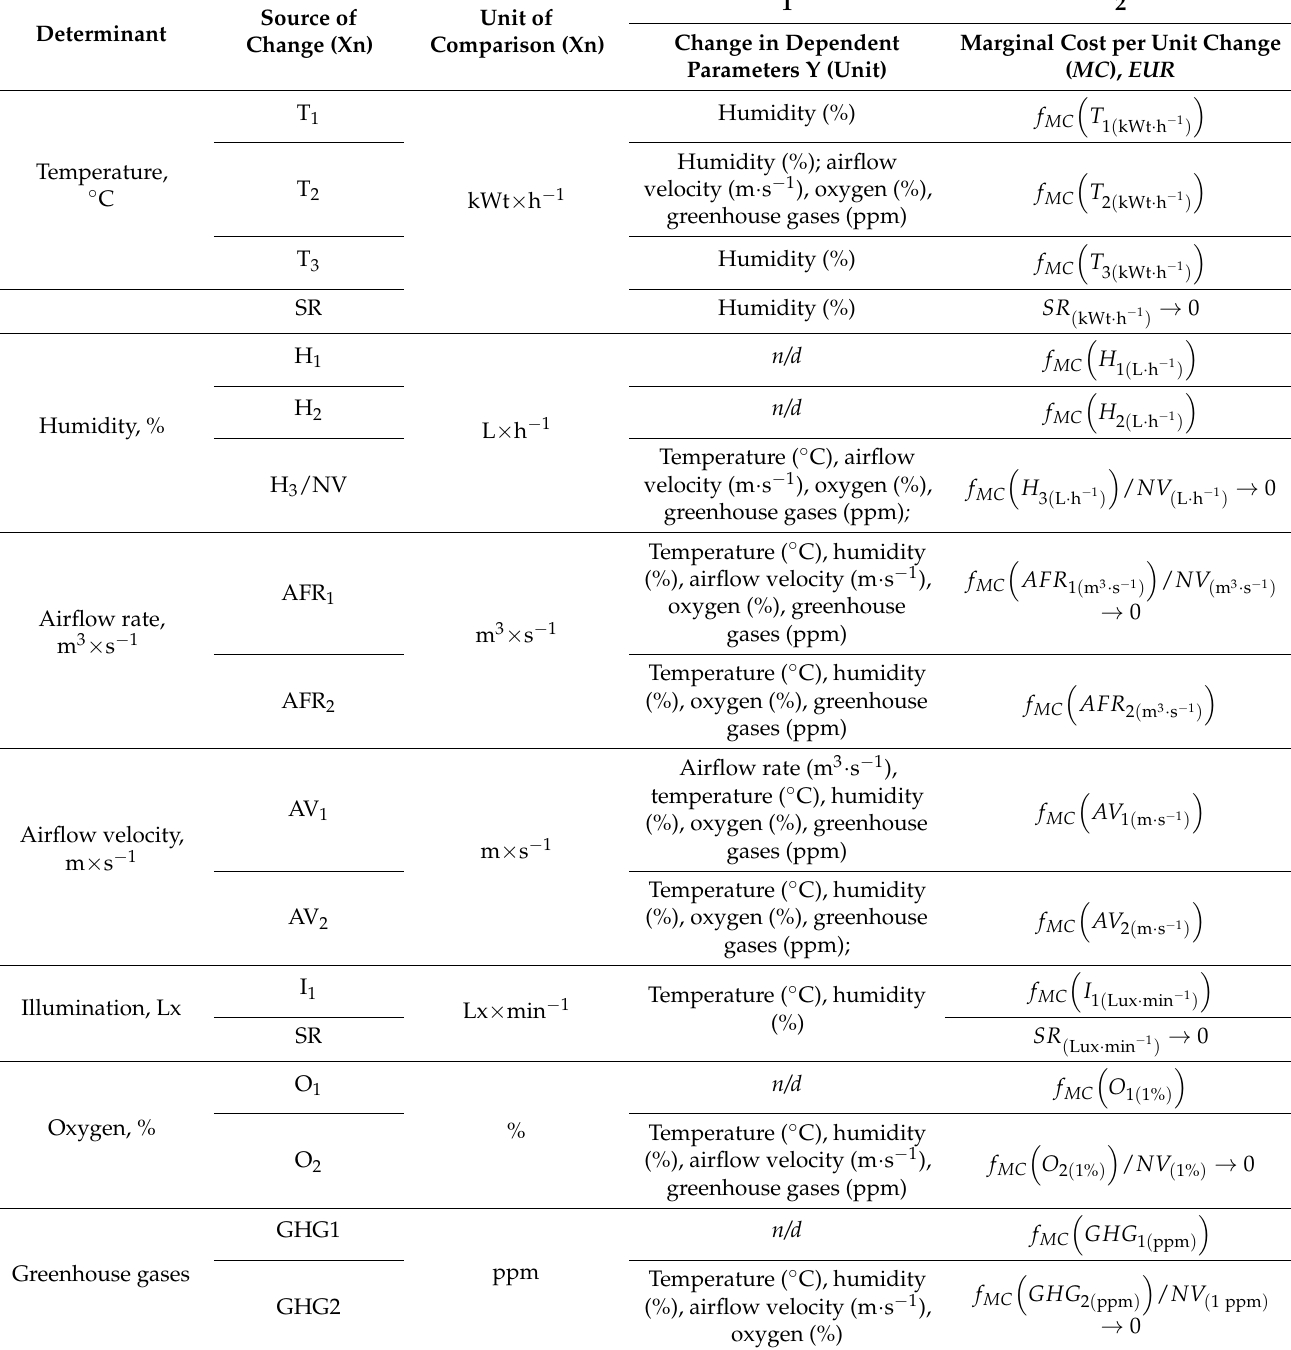
Table 1. Two basic sequential approaches for digital algorithms for automatic climate